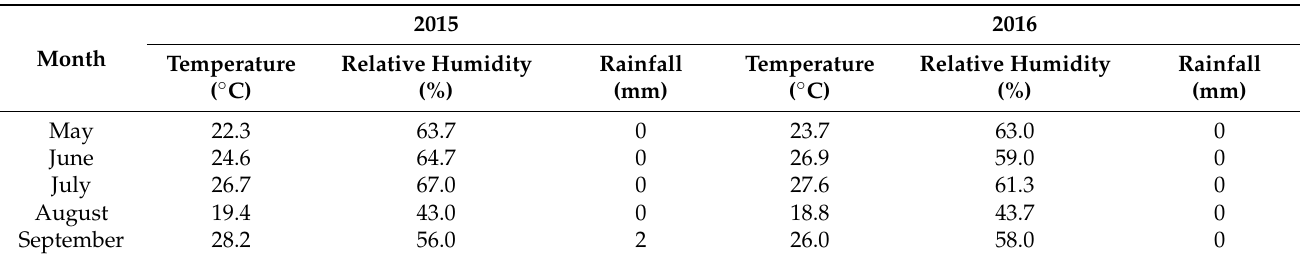
Table 1. Mean monthly climatic data from the nearest weather station (longitude: 29 ◦ 57 (cid:48) ; latitude: 31 ◦ 12 (cid:48) ; elevation: 3.4 m) at the experimental location for 2015 and 2016.